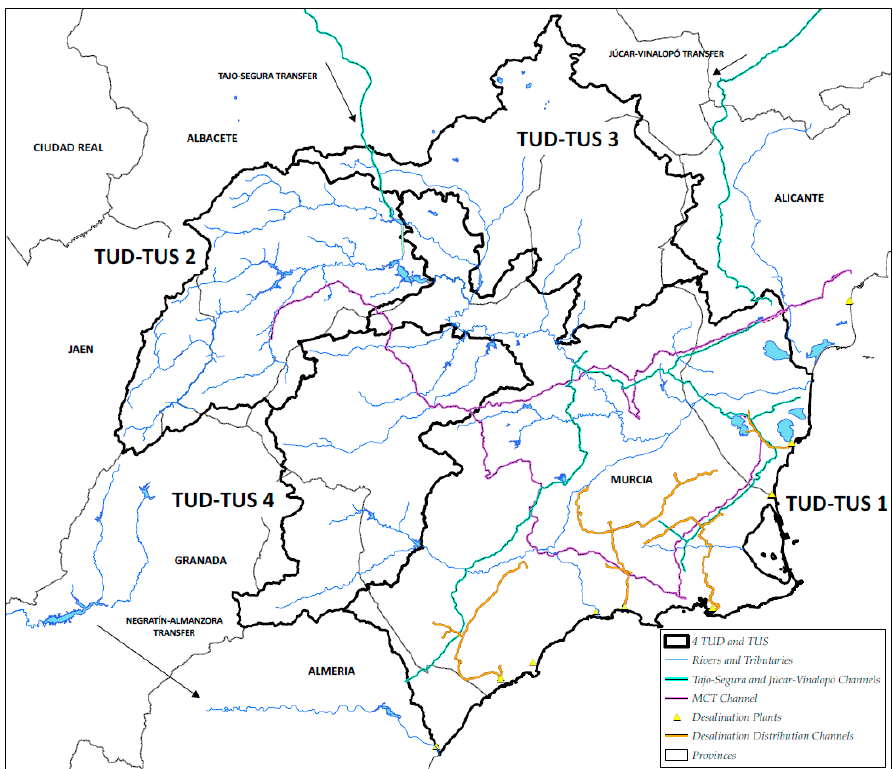
Figure 4. Territorial Unit in the SRB. Source: own elaboration based on